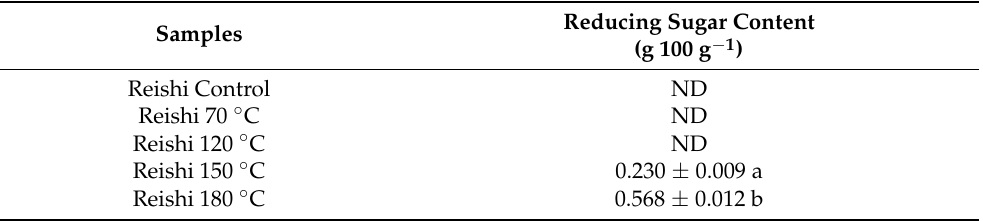
Table 1. Effect of heat treatment on reducing sugars content (mean ± StDev) of Reishi mushroom ( G. lingzhi ).